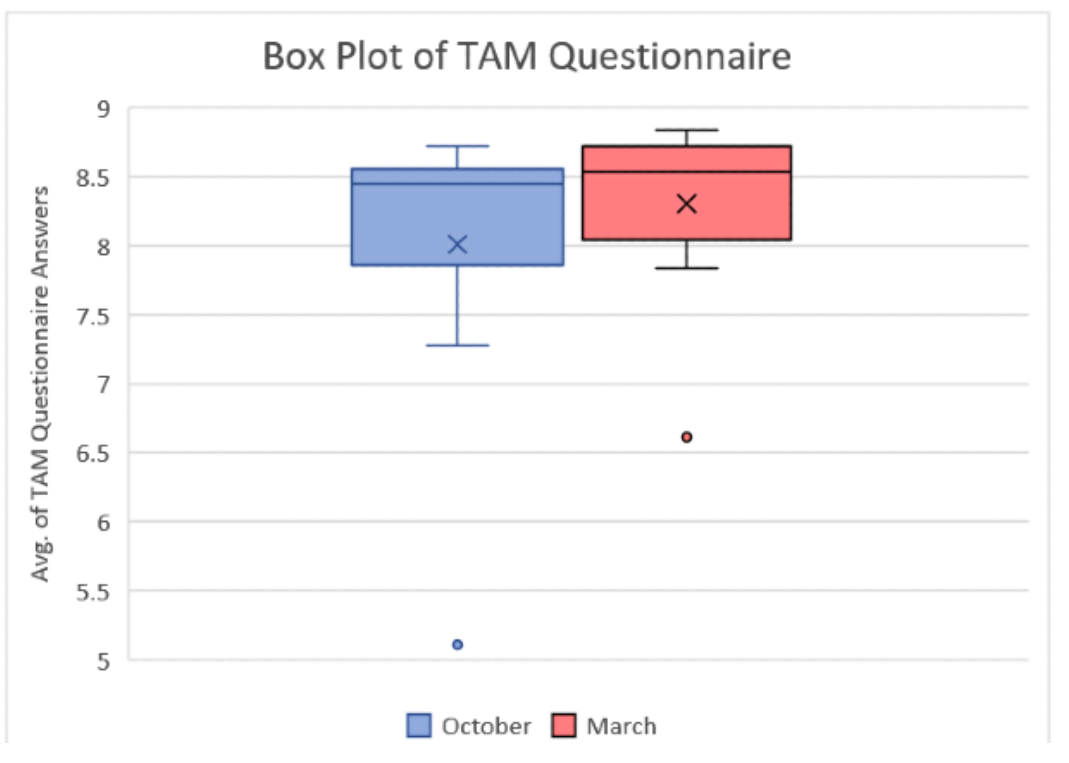
Figure 13. Box plot of TAM questionnaire answers of educators from the first (October) and second (March) sessions. TAM: Technology Acceptance